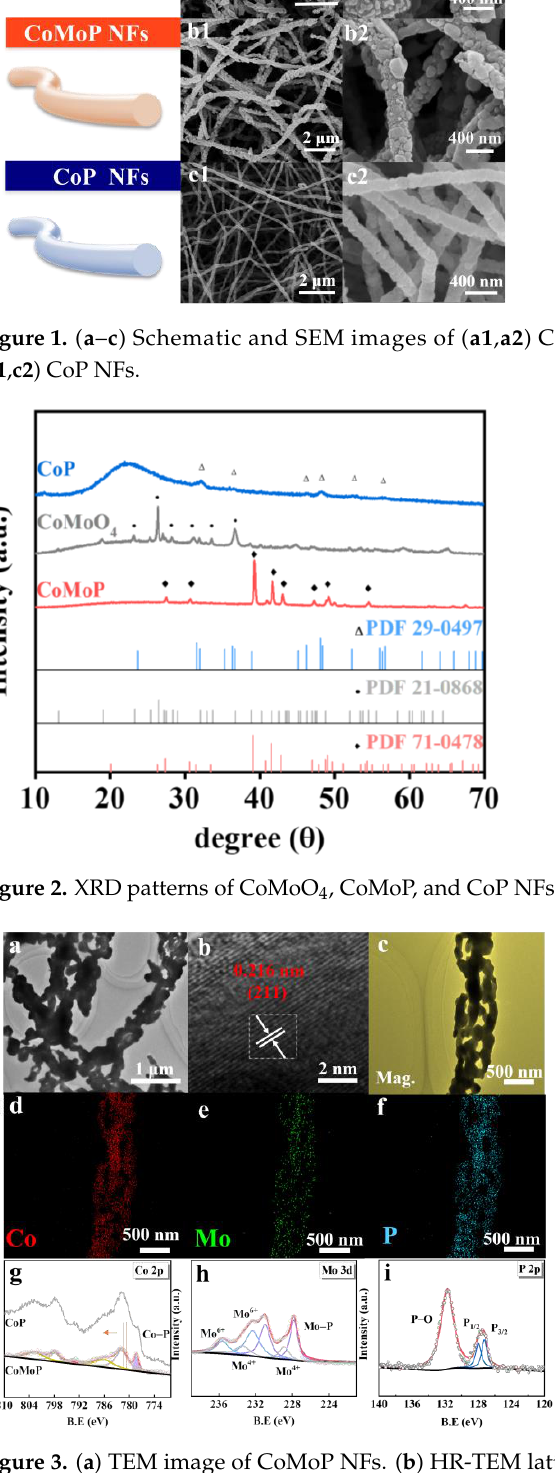
Figure 3. ( a ) TEM image of CoMoP NFs. ( b ) HR-TEM lattice image of CoMoP NFs. ( c ) Magnified TEM image of CoMoP NFs. ( d – f ) corresponding element mappings of CoMoP NFs. ( g ) XPS Co 2p spectra of CoMoP NFs and CoP NFs. ( h , i ) XPS spectra of Mo 3d and P 2p of CoMoP